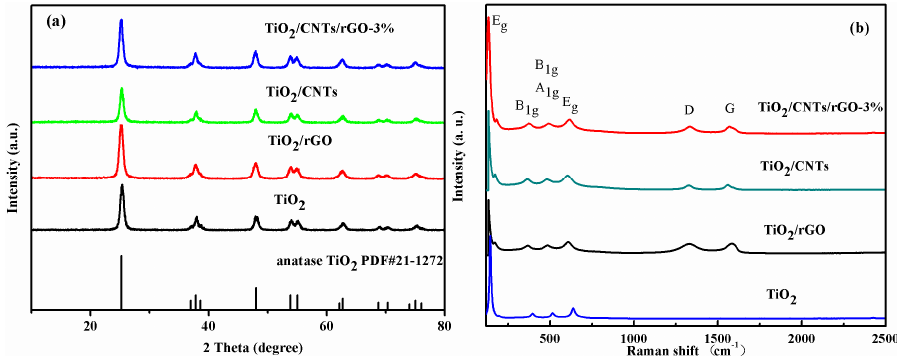
Figure 2. X-ray powder diffraction ( a ) (XRD) patterns; ( b ) Raman spectra of TiO 2 , TiO 2 /rGO, TiO 2 /CNTs and TiO 2 /CNTs/rGO-3%.